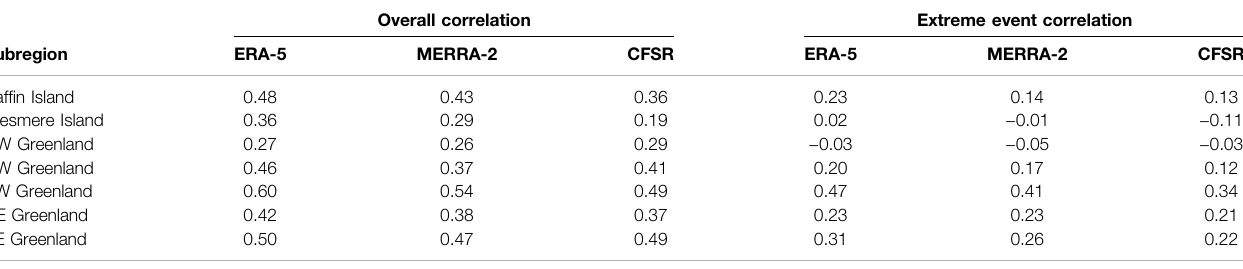
TABLE 4 | Correlation coef fi cient between the reanalyses and observations for precipitation amounts in each subregion. Values in the overall column represent the correlationsbetweenthereanalysesandobservationsforallprecipitationdayswithatleast1 mmofaccumulation,whiletheextremeeventscolumnonlyincludesdaysat or above the observed extreme threshold.